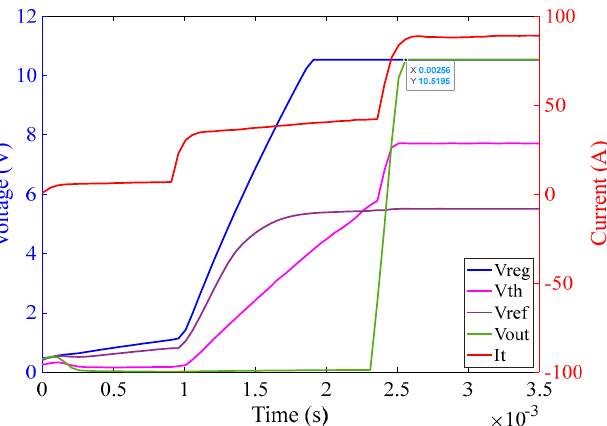
Figure 23. Activation time of the 1 Ω burden circuit at 60 A(rms) input current with 0° phase an ‐ gle.